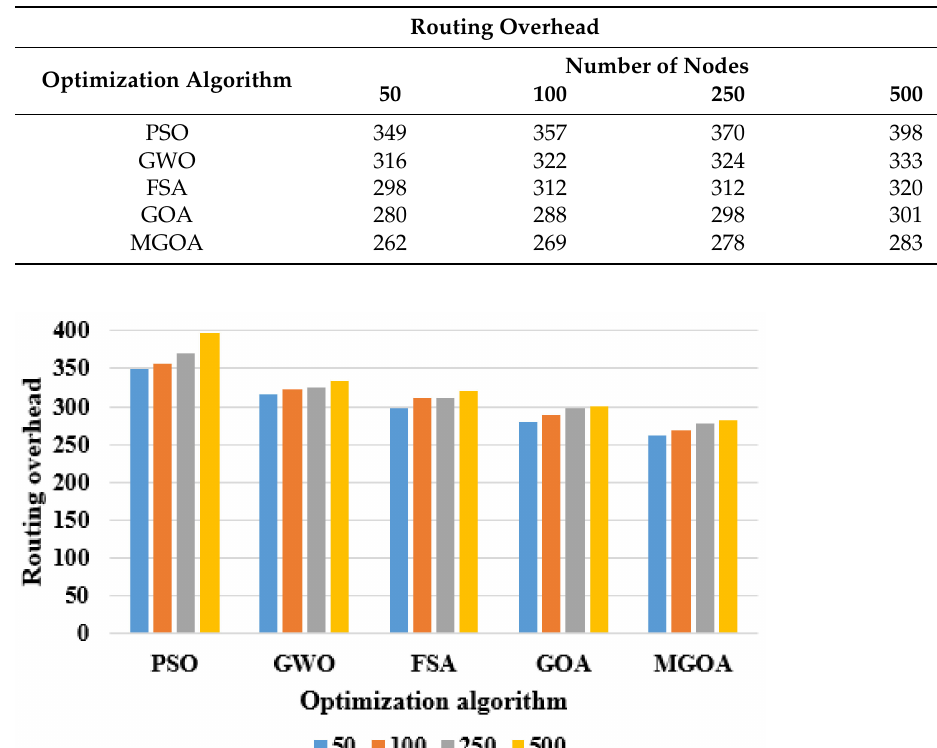
Table 5. Performance analysis of MGOA-WAVLCN in terms of routing overhead.